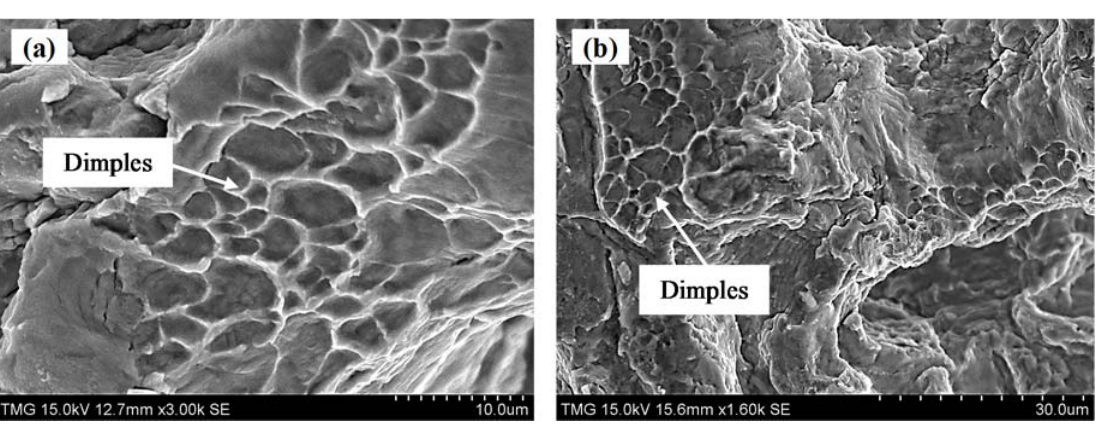
Figure 27. Dimples formation in the erosion crater for ( a ) non-treated Ti64 specimen; and for ( b ) DR-treated